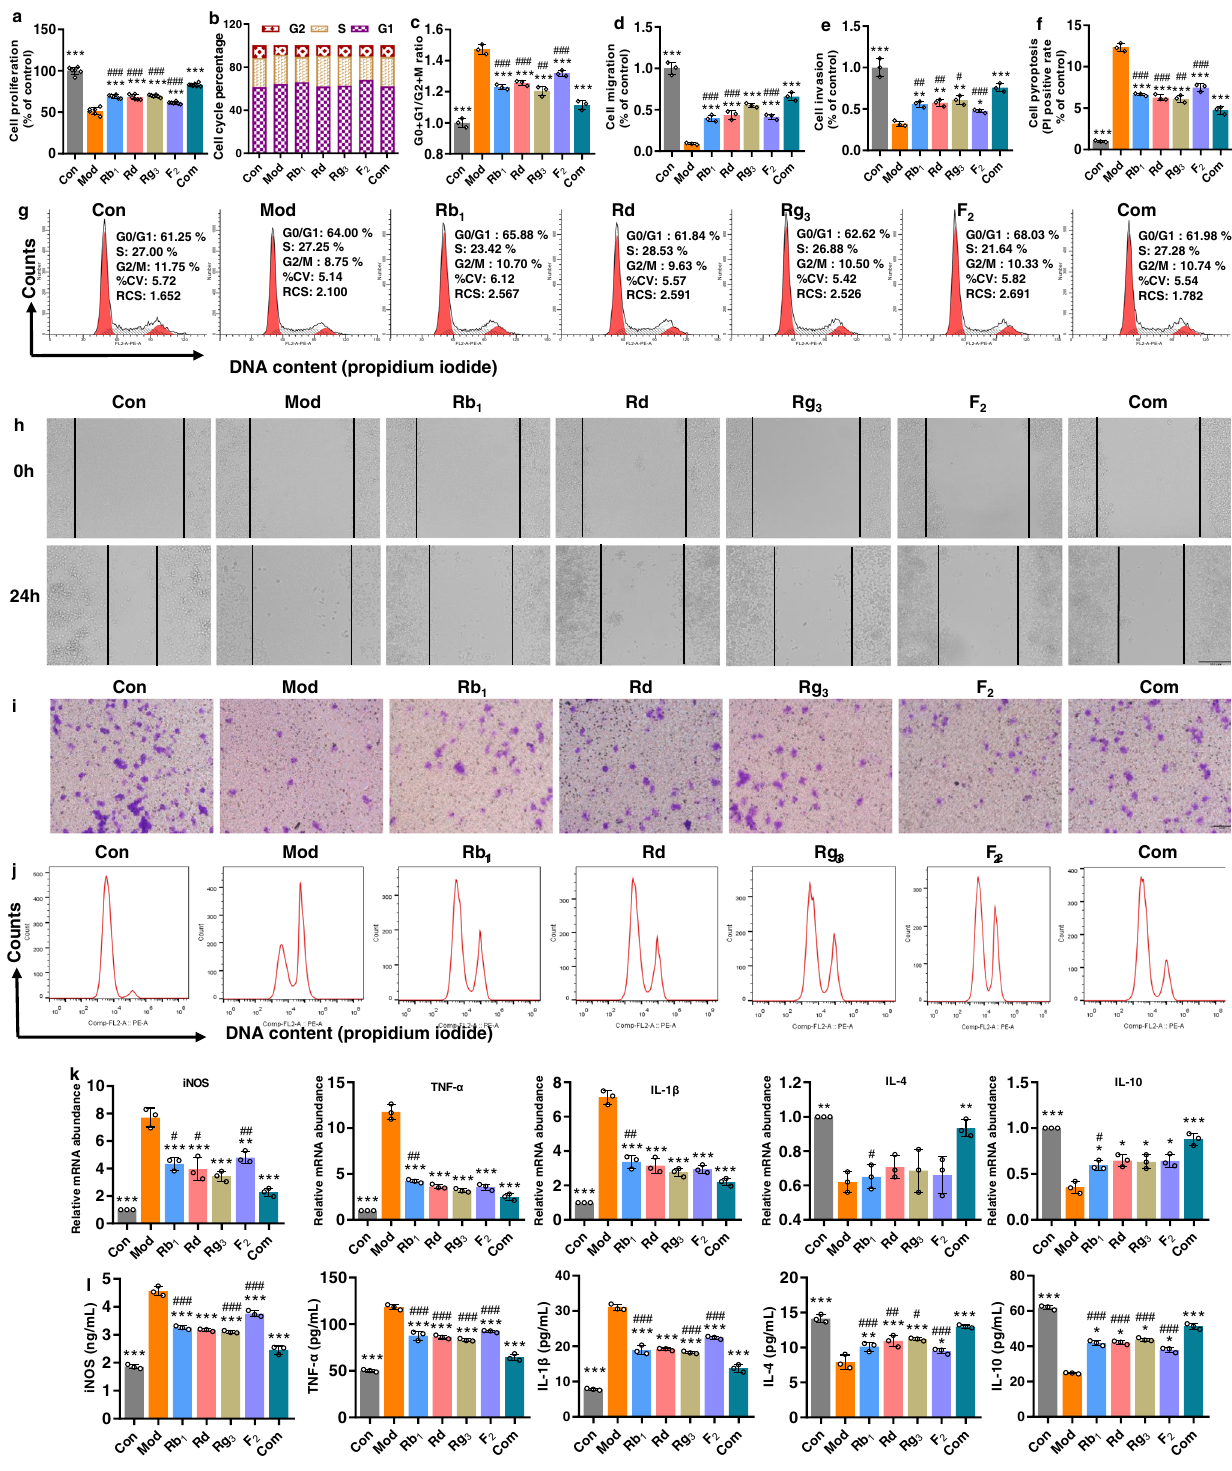
Fig. 2 Ginsenoside analogues ’ combination achieved stronger immunomodulatory activity in vitro than individual ginsenosides alone at the same dosages. a Cell proliferation ( n = 6), b , c , g cell cycle, d , h cell migration, e , i cell invasion, f , j cell pyroptosis, k qRT-PCR assay for mRNA expressions and l ELISA for levels of pro-in fl ammatory (iNOS, IL-1 β and TNF- α ) and anti-in fl ammatory (IL-4 and IL-10) cytokines ( b – l , n = 3). Data are expressed as mean ± SD. Compared with Mod, * P < 0.05, ** P < 0.01, *** P < 0.001; compared with Com, # P < 0.05, ## P < 0.01, ### P <